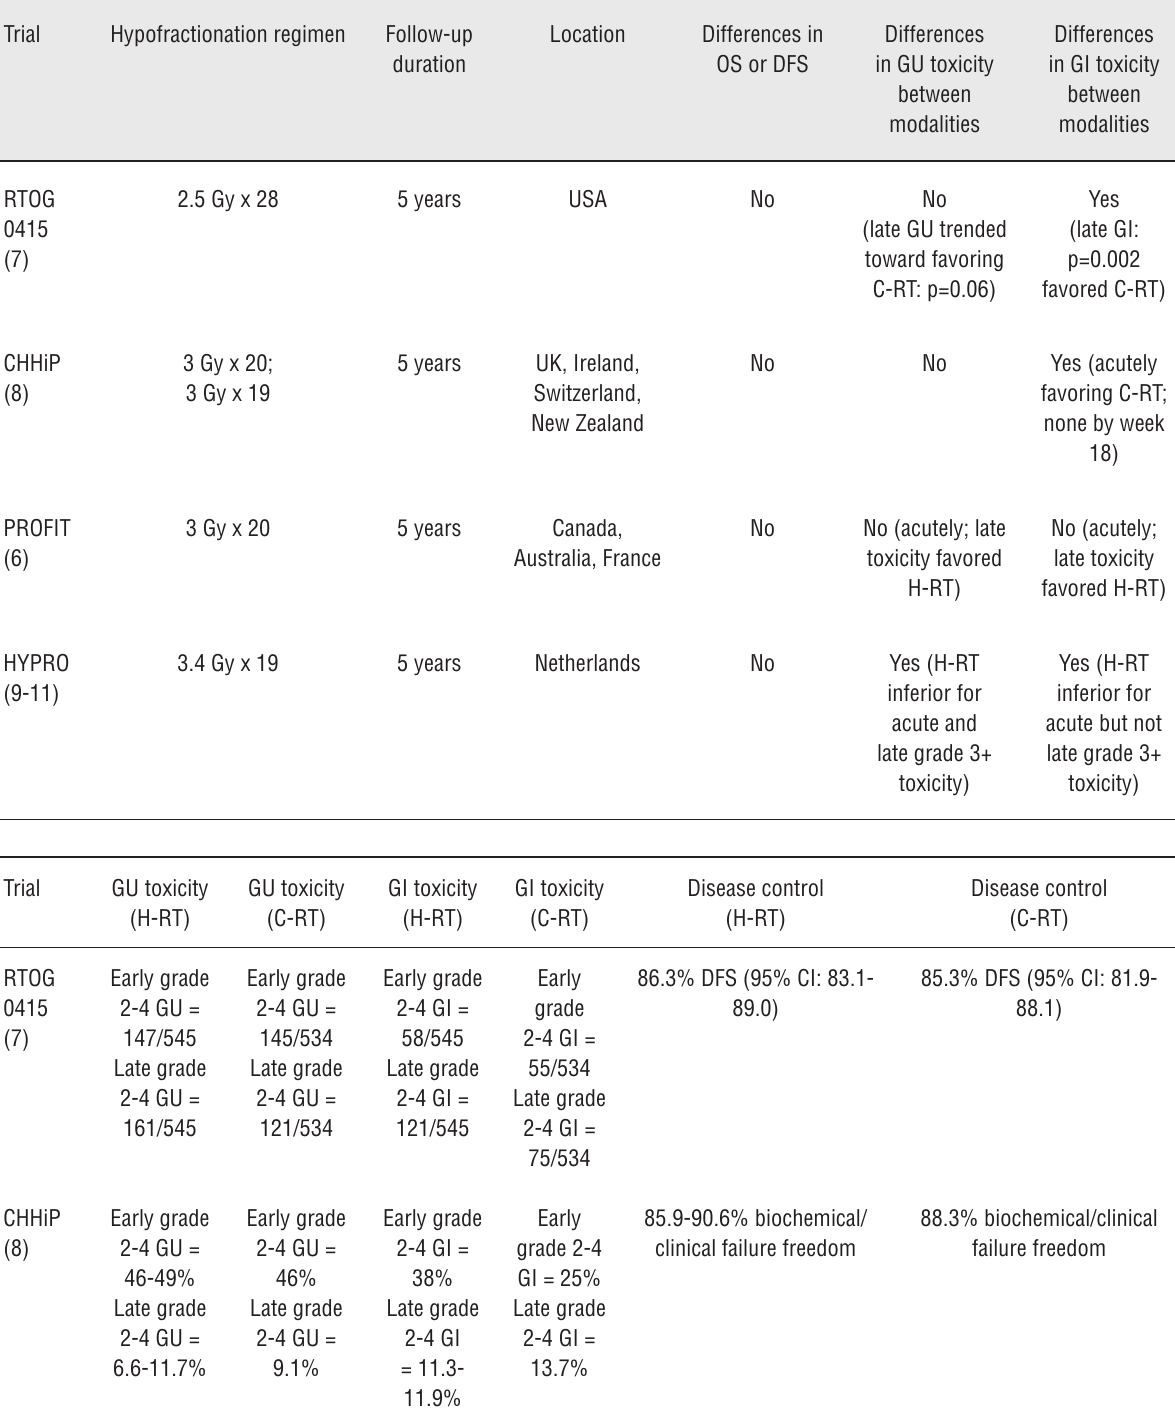
Table 1 - Summary of the four randomized clinical trials comparing hypofractionation (H-RT) with conventional fractionation (C-RT) for prostate cancer (OS = overall survival; DFS = disease-free survival; RFS = relapse-free survival; GU = genitourinary; GI = gastrointestinal; CI = confidence